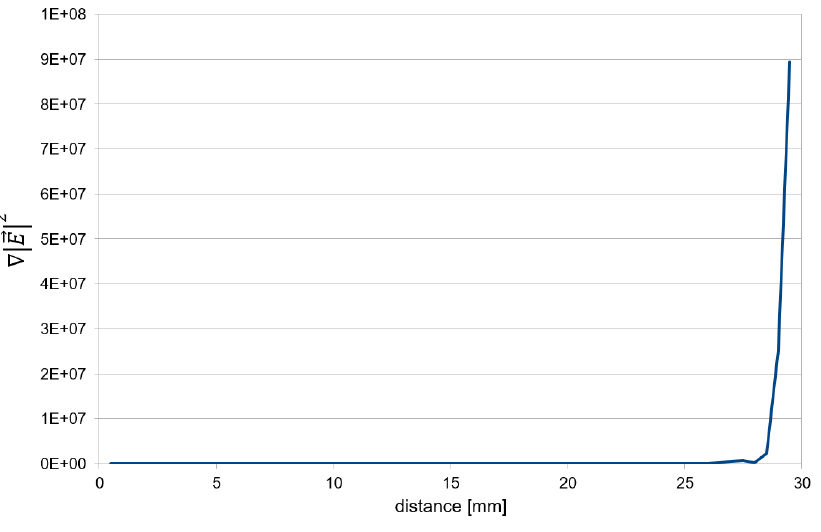
Figure 3 . Graphic representation of ∇|𝐸⃗⃗| Figure 3. Graphic representation of ∇| electrode along the shortest path between the electrodes for the voltage 14 kV. electrode along the shortest path between the electrodes for the voltage 14